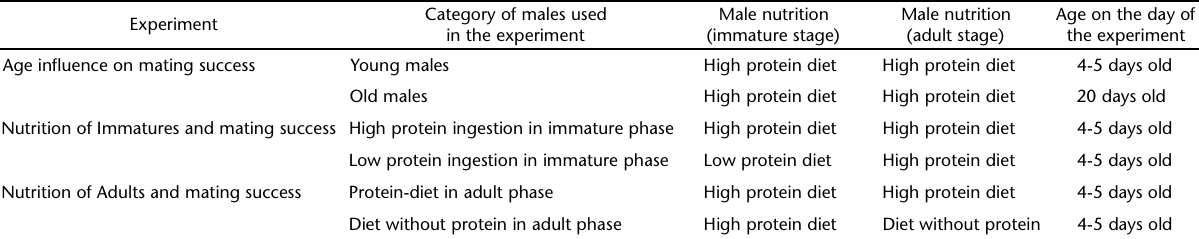
Table I. Categories and condition of males used in different experiments of mating success.